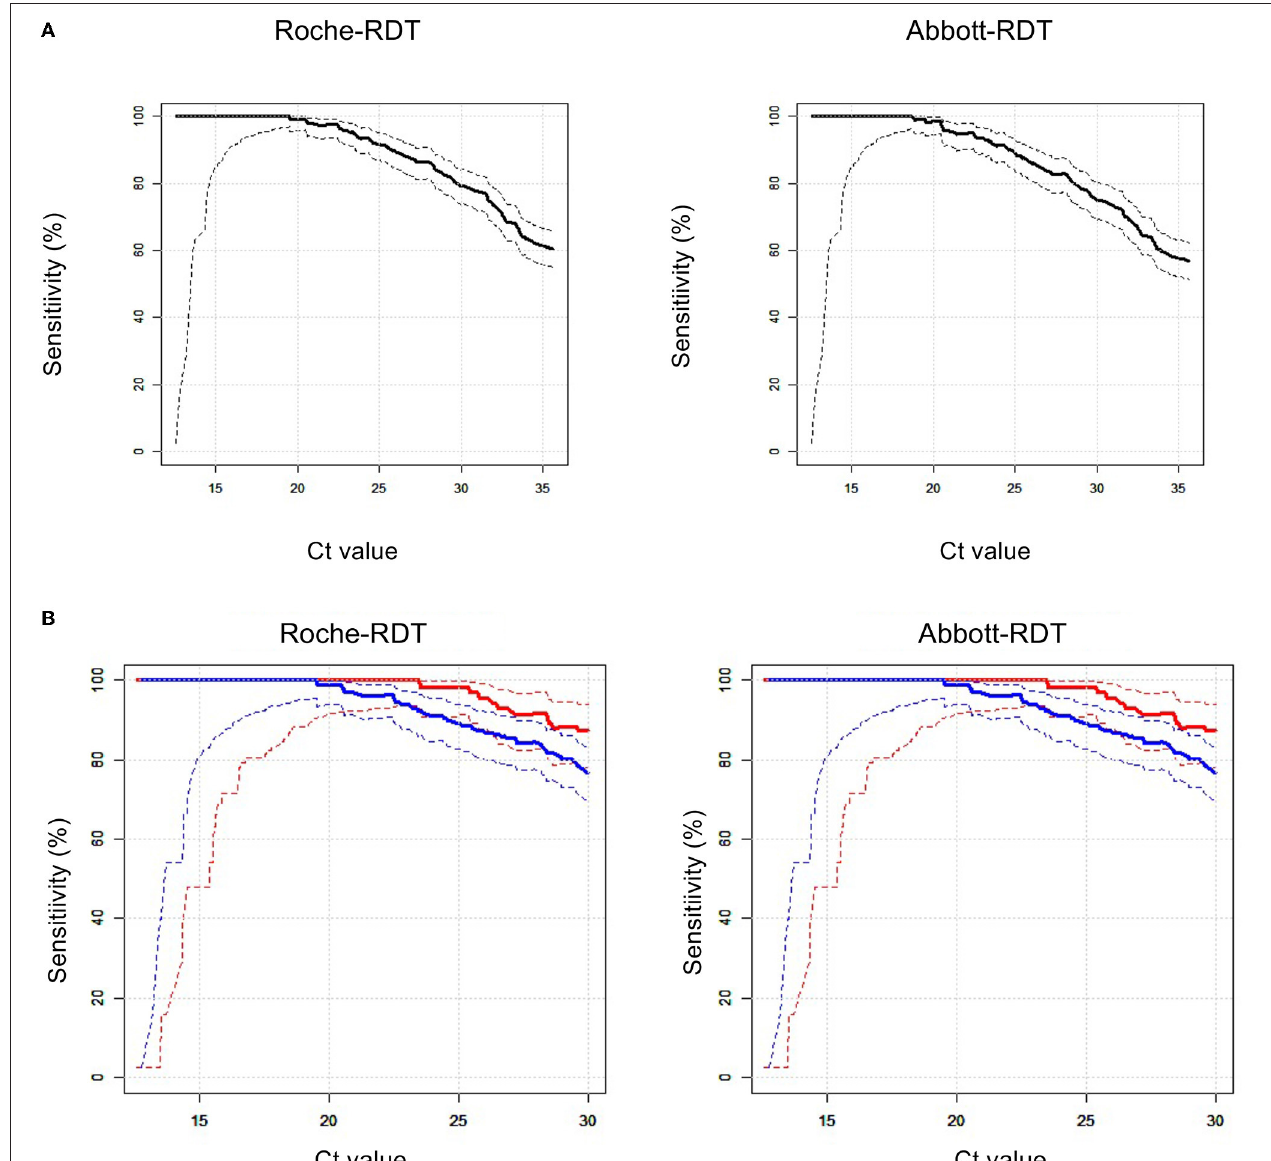
FIGURE 2 | Relationships between the sensitivities of RDTs vs. rRT-PCR cycle threshold (Ct) values. The solid lines indicate sensitivities, the dotted lines represent the upper, and the lower bounds the corresponding 95% confidence intervals. (A) left: Roche-RDT; right: Abbott-RDT. (B) Sensitivities according to SARS-CoV-2 genotypes. left: Roche-RDT; right: Abbott-RDT; red: NIM genotype; blue: SARS-CoV-2 Alpha